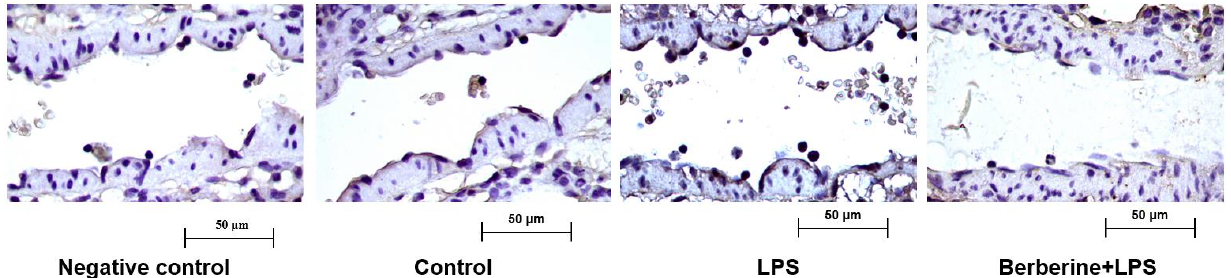
Figure 1. Berberine mitigated the lipopolysaccharide (LPS)-induced upregulation of Cx3cl1 in the endothelium of rat lung postcapillary venules. Rat lung tissues were subjected to immunohisto- chemical analysis to examine the expression of Cx3cl1. Negative control samples were processed using the same protocol, except for the use of anti-Cx3cl1 primary antibodies. Brown color in the endothelium indicates the expression of Cx3cl1. Four microphotographs representing the pulmonary section of the negative control, control, LPS (5 mg/kg bodyweight)-treated, and berberine (50 mg/kg bodyweight, intraperitoneal; 1 h)-treated/LPS (5 mg/kg bodyweight, intraperitoneal)-treated groups were shown.